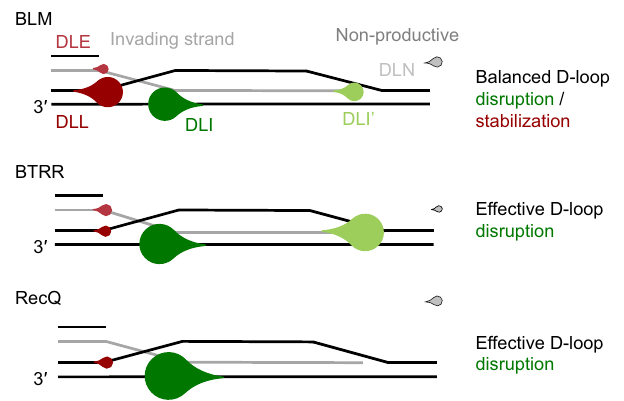
Fig. 9 D-loop processing pathway preference of BLM, BTRR and RecQ. Graphical presentation of the preference of binding orientations and the fraction of nonproductive unwinding events for the given helicase constructs. The tip of the droplets indicates the direction of unwinding. Relative sizes of droplets are proportional to the fractions shown in Fig. 7d and Fig. 8b. Con fi gurations leading to D-loop disruption are colored with green shades, whereas those leading to D-loop stabilization in an in vivo context are colored with shades of red. Nonproductive events are represented by gray